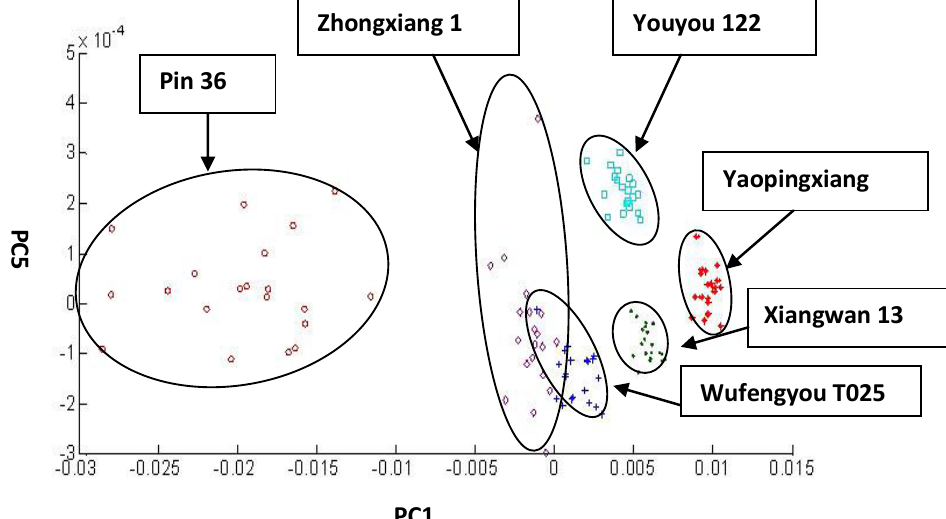
Figure 8. Classification of the six rough rice varieties using PC1 and PC5.